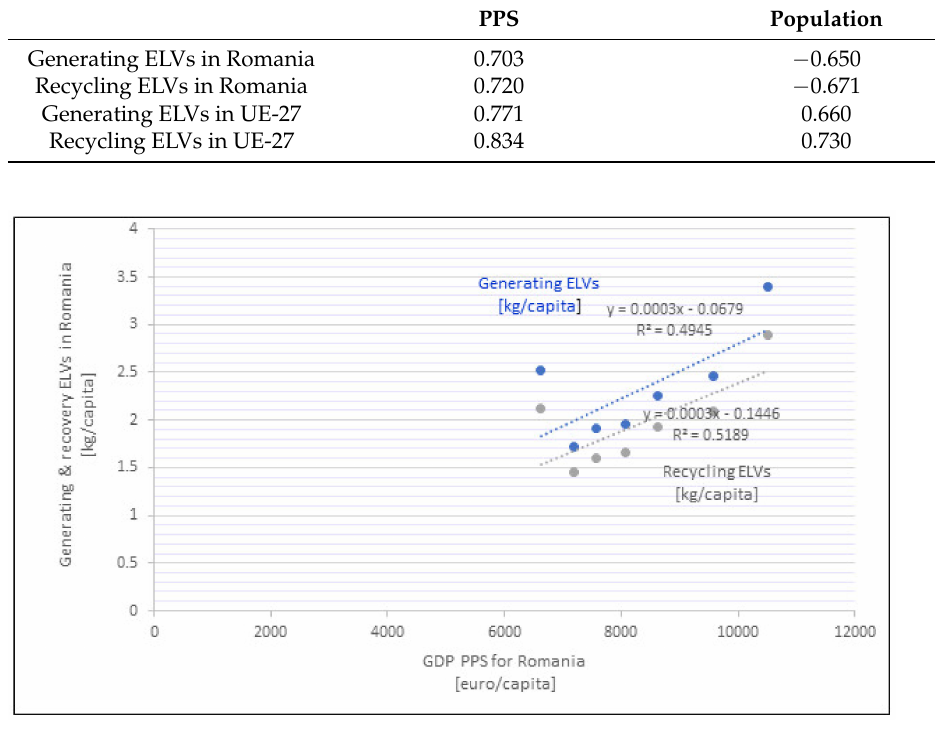
Figure 9. Correlation between ELVs generating and recycling in Romania during 2012–2018 and GDP PP in the same